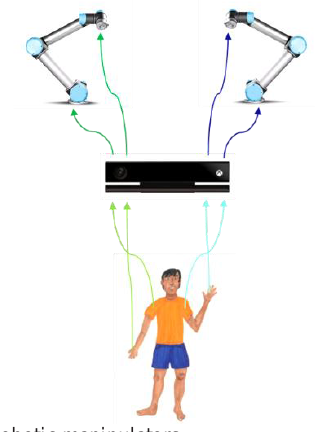
Fig. 1. Idea – remote control of robotic